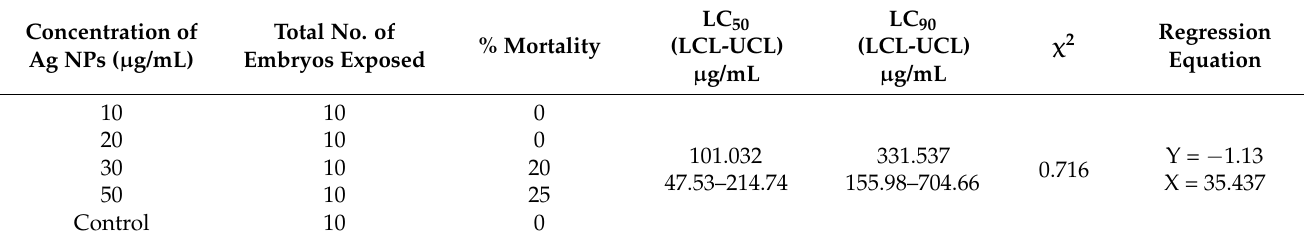
Table 8. Toxicity assay of Priestia aryabhattai -mediated Ag NPs on embryos.